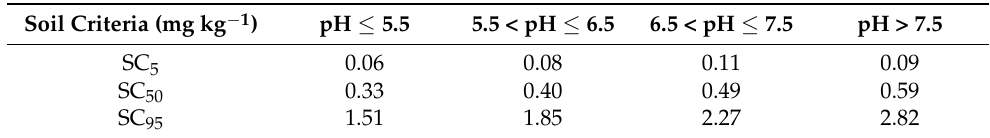
Table 4. The derived soil criteria (SC 5 , SC 50, and SC 95 ) of Cd for rice safety according to soil pH ranges.